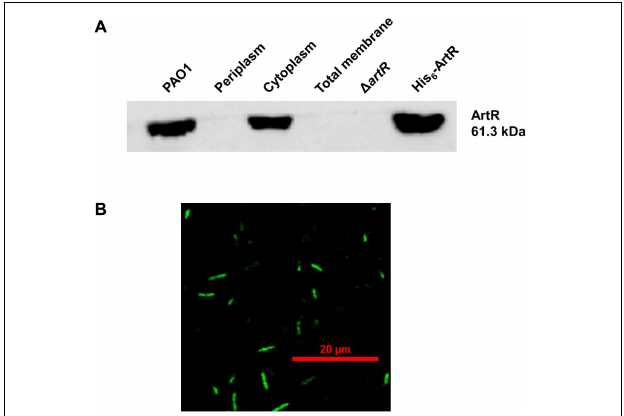
FIGURE 6 | Subcellular localization of ArtR. (A) Localization of ArtR in the cell fractionations analyzed by Western blot. Immunoblot of crude extracts probed with the polyclonal antibody (1:3,000) directed against ArtR protein. Cells of a 50 ml culture in LB were fractionated. Specimens of the whole cell preparation of PAO1, periplasm, cytoplasm, total membrane, the total cell extract of (cid:49) artR (negative control), and His 6 -ArtR (positive control) were separated by SDS-PAGE and probed by immunoblotting. (B) The localization of ArtR-GFP in PAO1. P. aeruginosa PAO1 carrying pME6032- artR-gfp was cultured with 0.5 mM IPTG at 37 ◦ C for 4 h. The cells were examined and imaged by Nikon A1 confocal laser scanning microscopy.